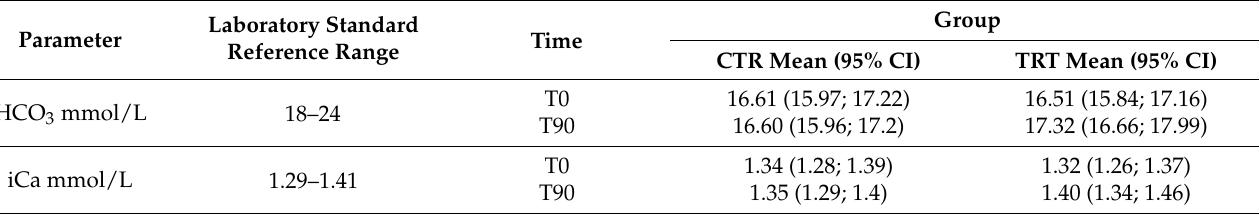
Table 5. Serum bicarbonate (HCO 3 ) and ionized calcium (iCa).